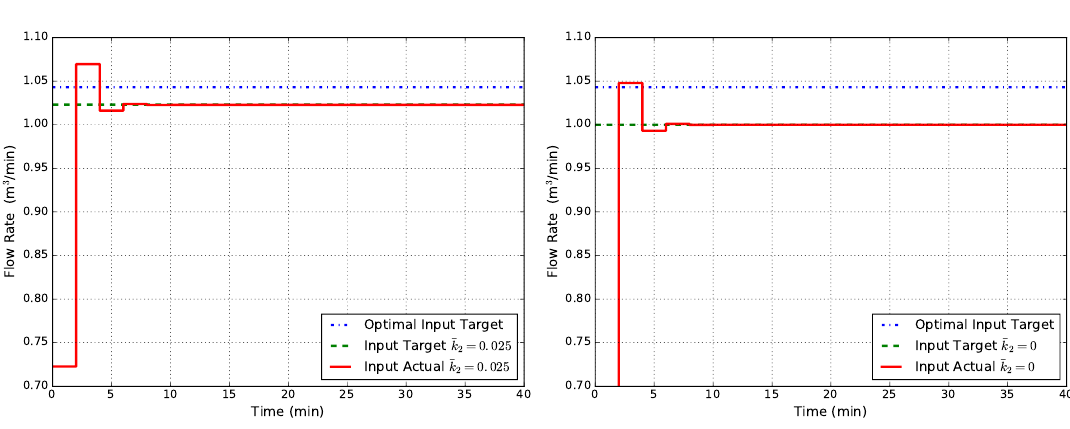
Figure 2. Closed-loop flow rate Q obtained with standard EMPC0 for two cases of uncertainty in k 2 : ¯ k = 0.025 ( left ) and ¯ k = 0 ( right 2 2